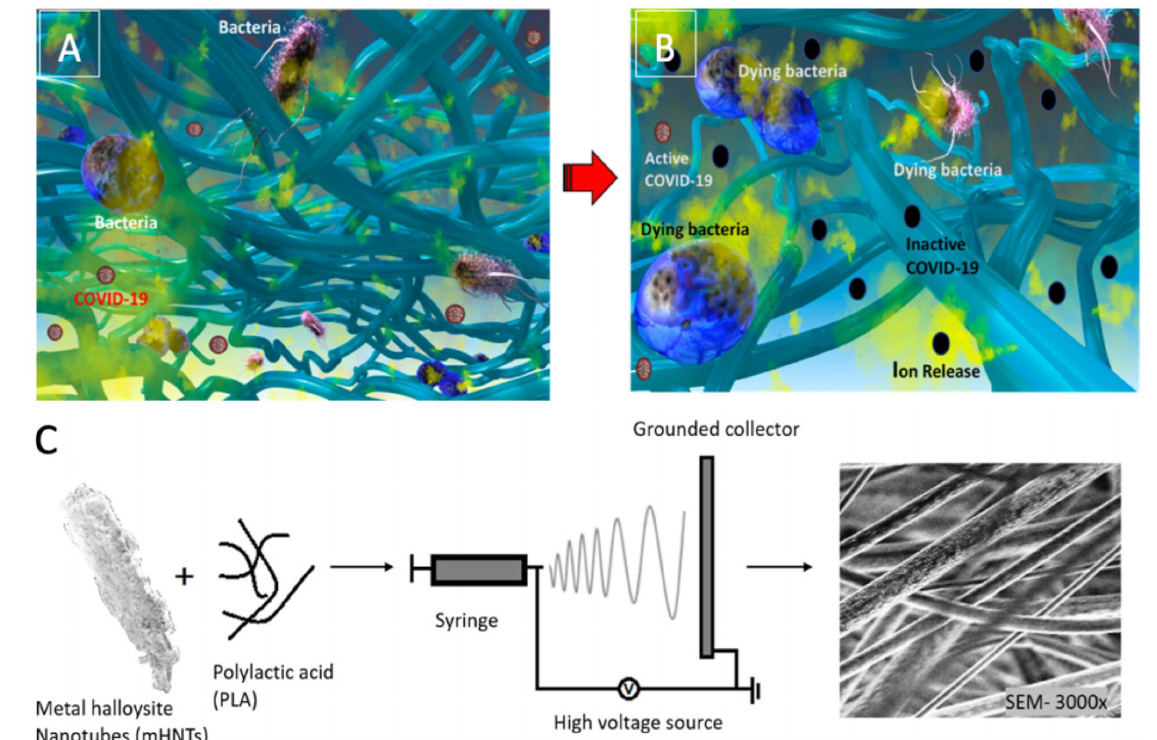
Figure 4. ( A,B ) Graphic depicting metal-coated HNTs (mHNTs) embedded in blow-spun fibers used to inhibit bacterial growth and inactivate viruses. ( C ) The mHNTs and PLA electrospun fibers were used as part of a filter system to be used in N95 mask [67].